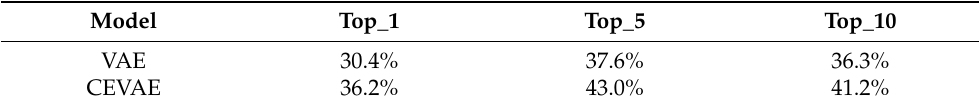
Table 2. Effect of channel expansion on the Flowers dataset.